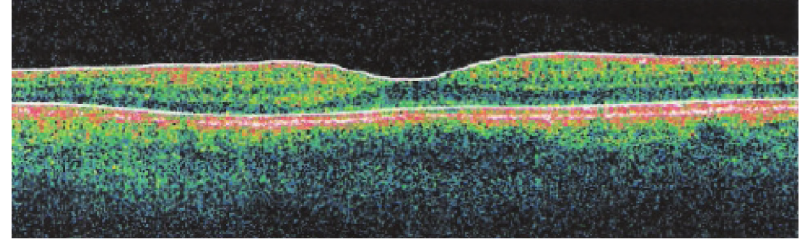
Figure 3 : Medmont visual field test showing a mild supero-temporal defect. The blind spot was marginally enlarged on automated analysis.